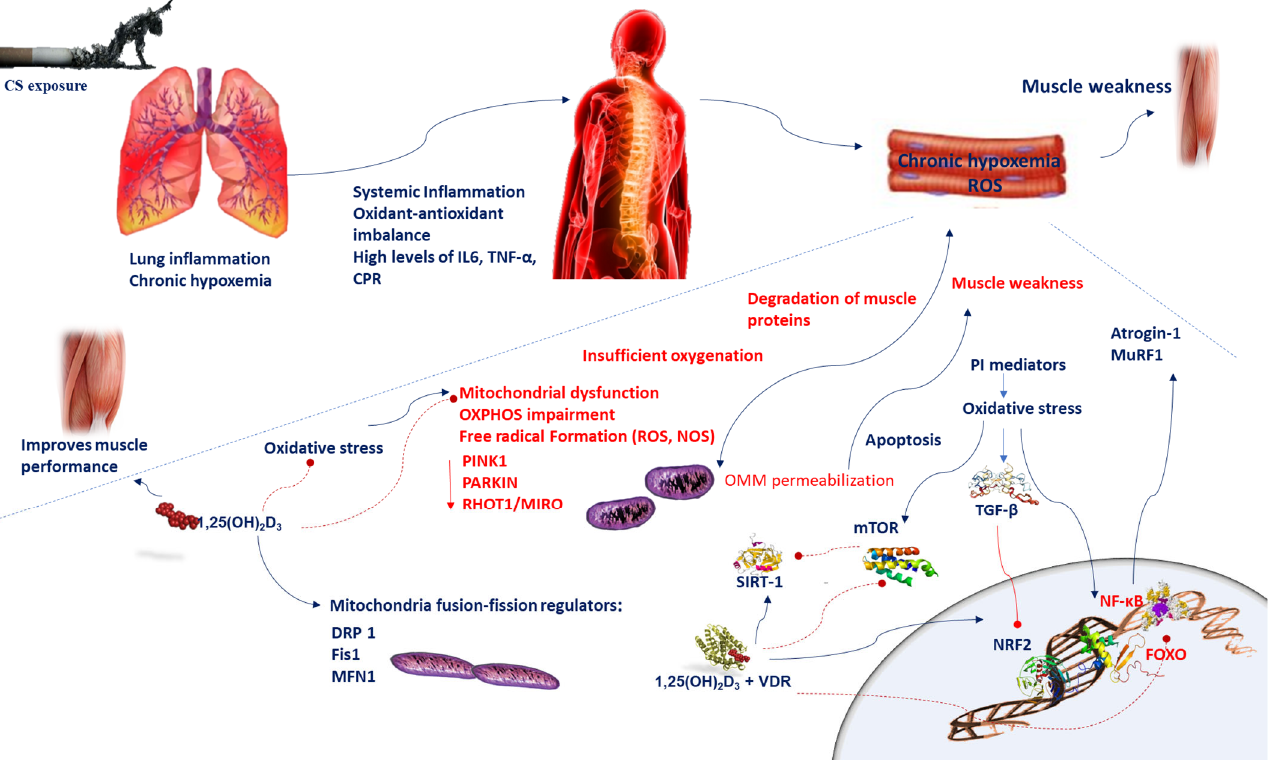
Figure 1. Chronic hypoxemia contributes to inflammation, which generates mitochondrial dysfunction, impairments in mitochondrial turnover, and oxidant–antioxidant imbalance. Reduced respiration causes insufficient oxygenation and mitochondrial dysfunction, which in turn leads to alteration of mitochondrial OXPHOS and increases ROS levels. A disproportionate stimulation of fission induces mitochondrial dysfunction. Reduction in the mitochondrial fusion factor OPA1 impairs the mitochondrial network and promotes apoptosis. Blockade of fission Fis1 or Drp1 inhibits mitochondrial fragmentation. Oxidative stress triggers the TGF- β signaling pathway, which induces inhibitory effect on Nrf2, which in turn inhibits endogenous antioxidants. Oxidative stress induces cellular senescence via FOXO transcription factors and decreases SIRT-1 expression and enzyme activity; ROS activate the PI3K-mTOR pathway. Vitamin D supplementation prevents the mitochondrial dysfunction and oxidative stress by setting MFN1/2, OPA1, and Drp1 expression. Oxidative stress activates NF- κ B and FOXO pathways which influences muscle wasting in COPD patients. Vitamin D and VDR represses NF- κ B and modulates the post-translational modification and function of FoxO proteins. The beneficial effects of SIRT-1 on mitochondrial function are regulated by vitamin D, which acts by increasing SIRT-1 formation. Abbreviations: CPR = C-reactive protein; Drp1 = dynamin-related protein 1; 1,25(OH)2D3 = 1,25-dihydroxyvitamin D3; Fis1 = fission protein 1; FOXO = forkhead box O; IL-6 = interleukin-6; MFN1/2 = mitofusin-1/2; mTOR = mammalian target of rapamycin; MuRF1 = muscle-specific RING finger protein 1;NOS = nitrogen species; Nrf2 = nuclear factor erythroid 2-related factor 2; NF- κ B = nuclear factor kappa; OPA1 = optic atrophy protein 1; OXPHOS = oxidative phosphorylation; PI3K = phosphatidylinositol-3-kinase; ROS = reactive oxygen species; RHOT-1/MIRO = Ras homolog family member T-1; TGF- β = transforming growth factor-beta; TNF- α = tumor necrosis-alpha; sirtuin-1 = SIRT-1; VDR = vitamin D receptor. Chronic hypoxemia, generating high levels of ROS in the lungs, is common in pa- tients with COPD and is often associated with muscle oxidative stress [56,57].